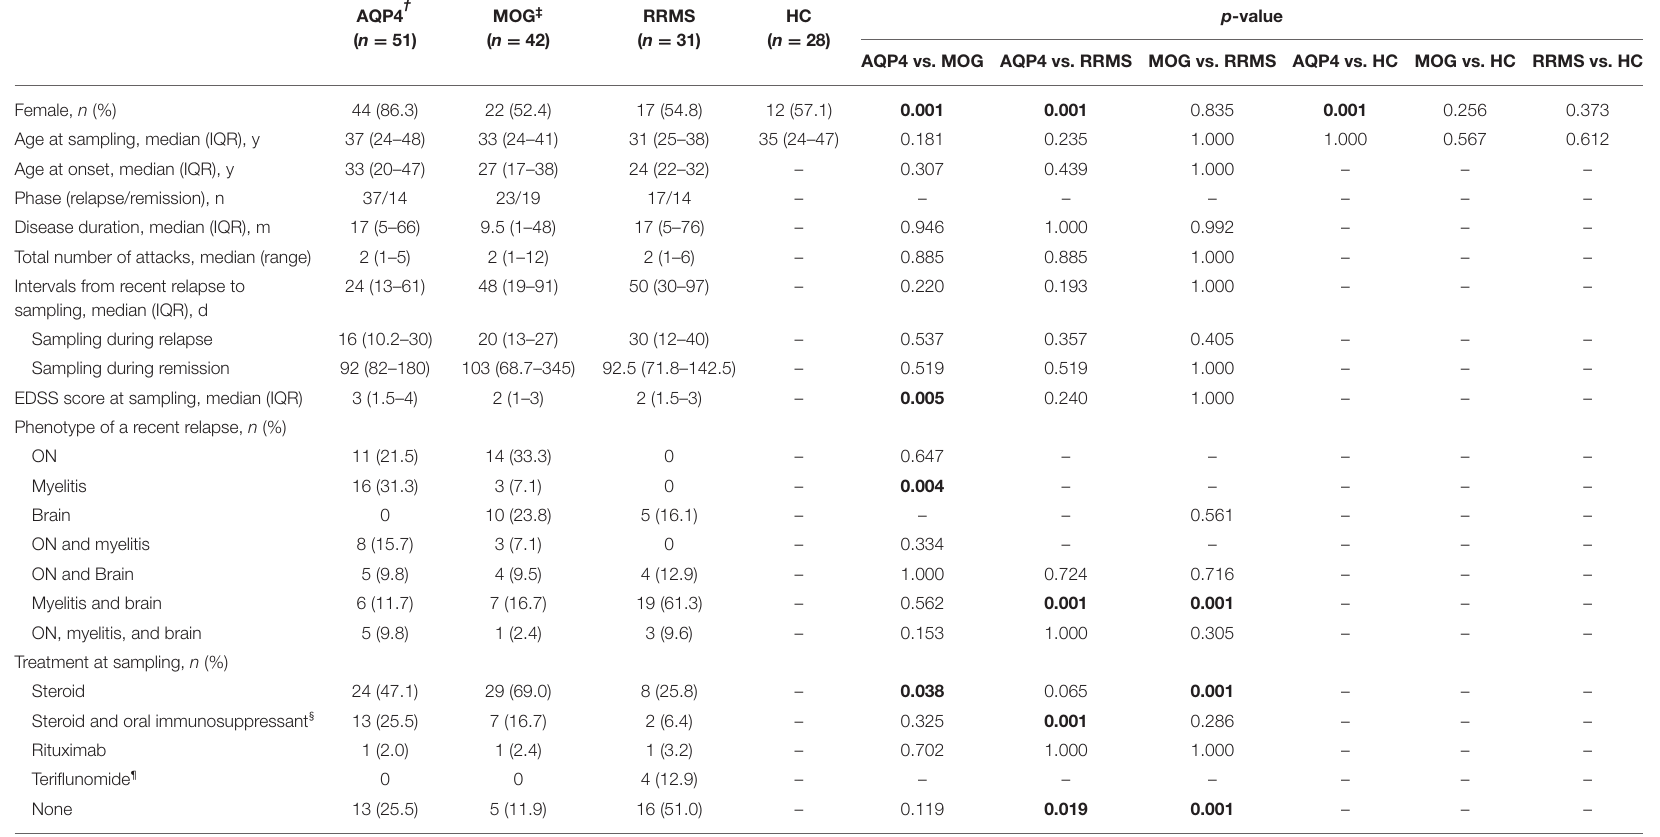
TABLE 1 | Demographic and clinical data of participants at